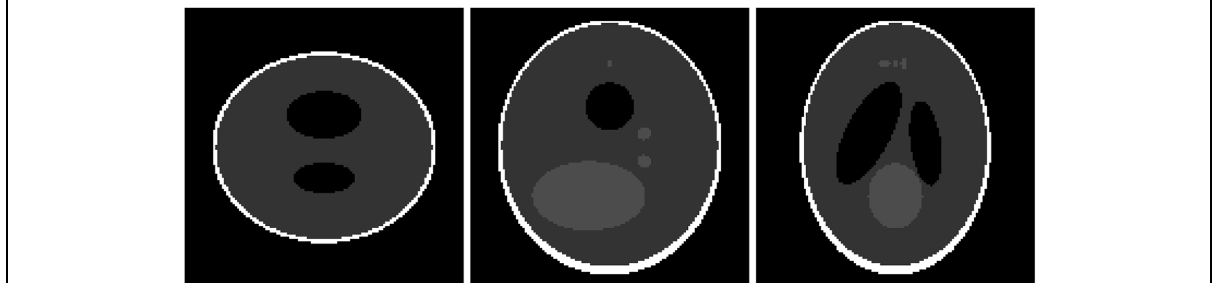
Fig. 19 The true image of the 3D Shepp-Logan phantom. Three orthogonal central cuts are shown from left to right: the y-z plane, the x-z plane, and the x-y